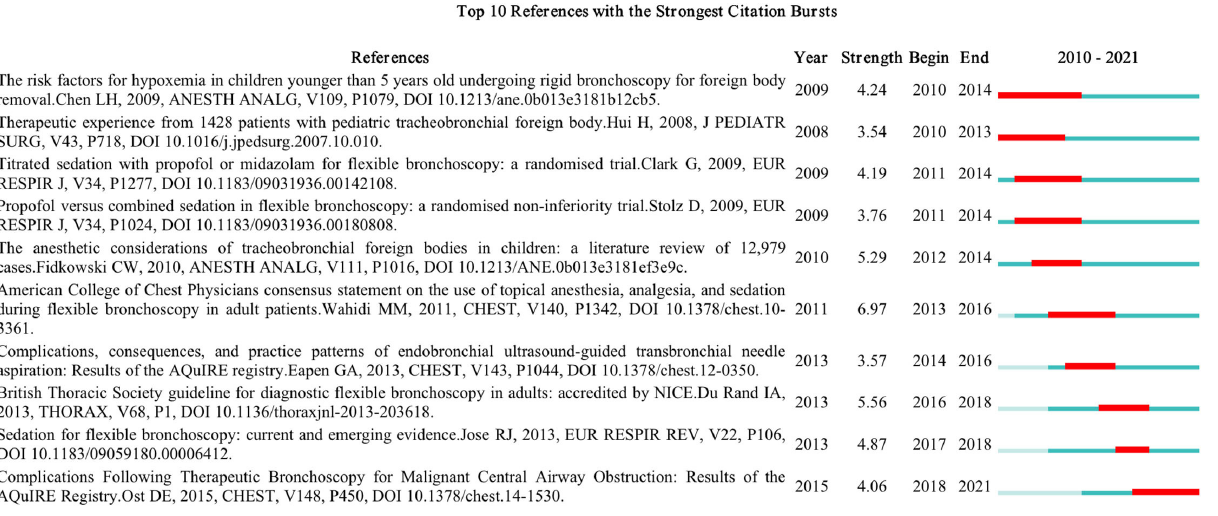
enabling our research results to be more accurate and